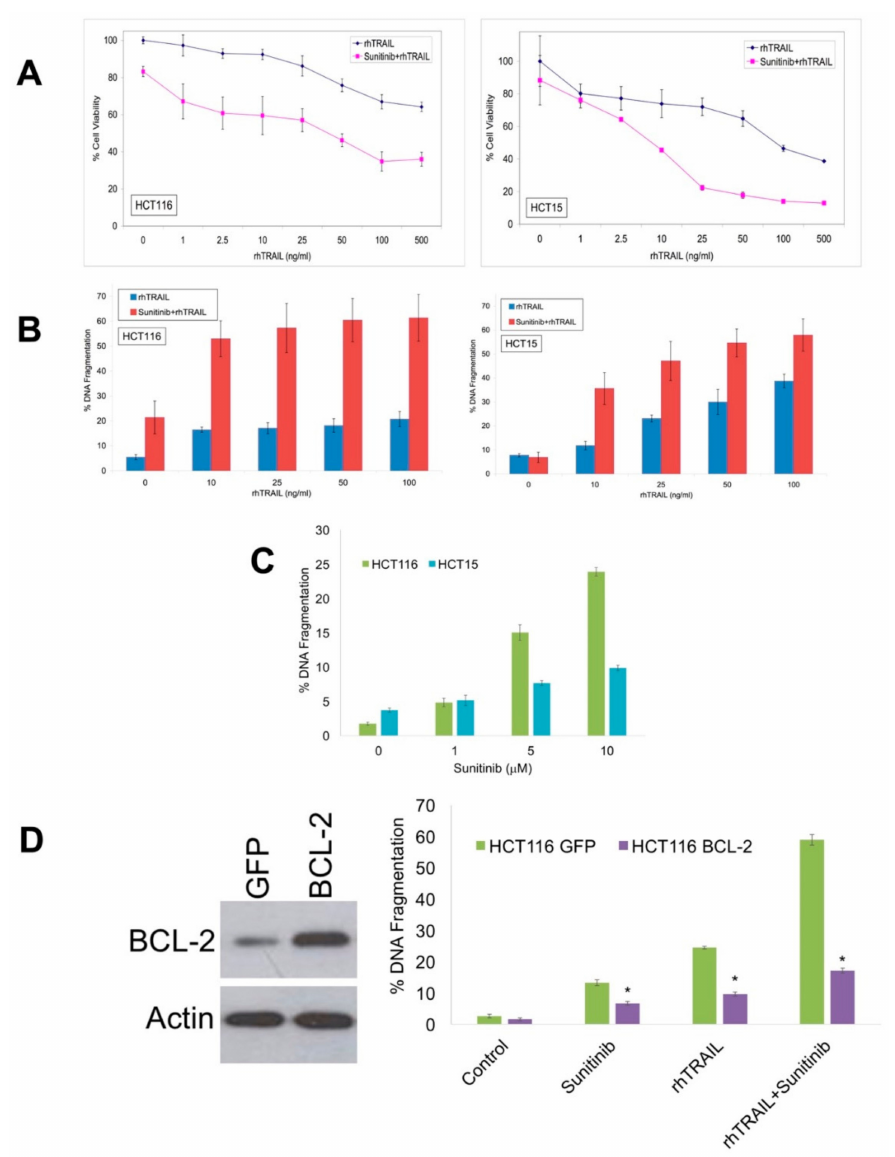
Figure 1. Sunitinib enhances the activity of recombinant human tumor necrosis factor-related apoptosis-inducing ligand (rhTRAIL) in colon cancer cell lines. ( A ) Cells were treated for 72